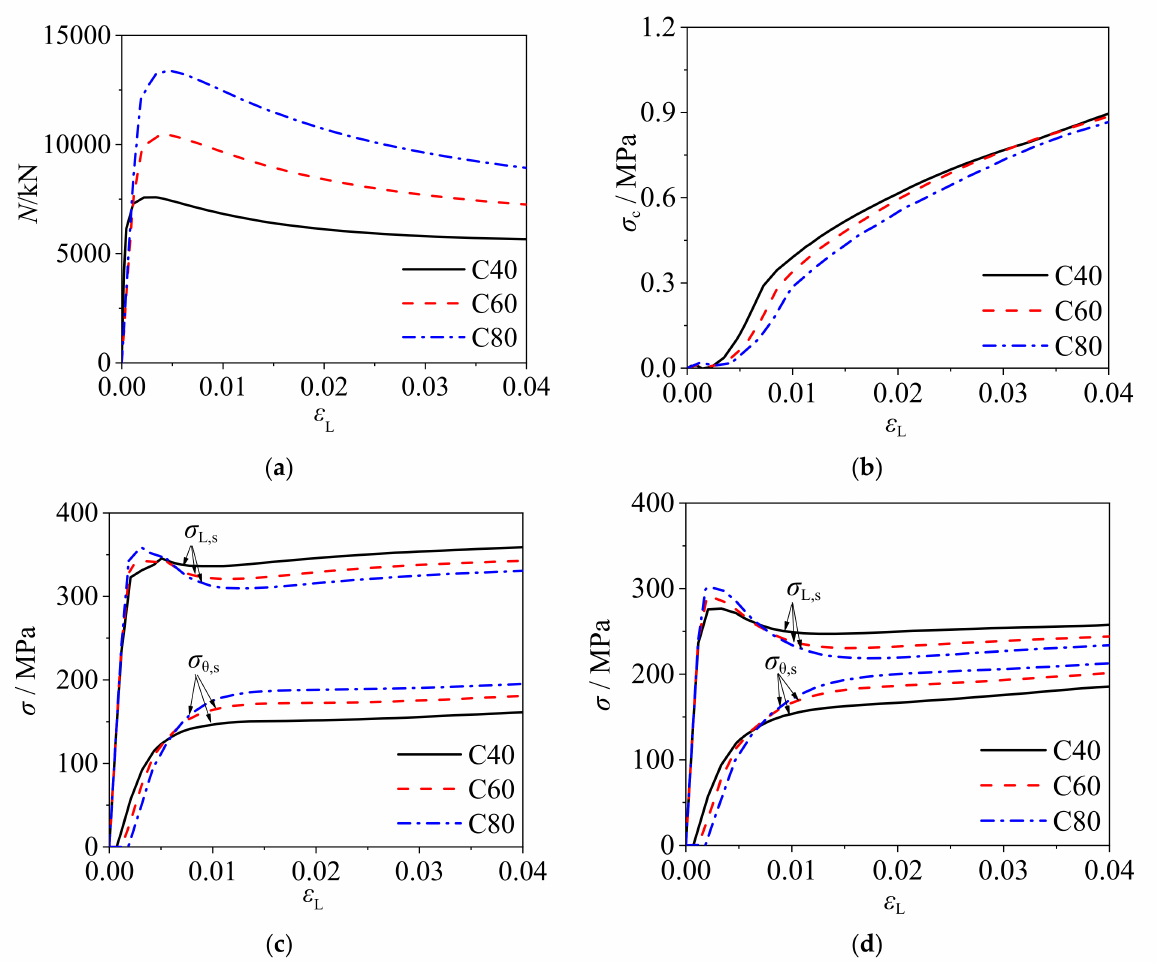
Figure 9. The influence of concrete strength on the mechanical performance of CFCFST stub columns: ( a ) load–strain curves, ( b ) radial stress–strain curves of concrete, ( c ) stress–strain curves of steel tubes at endpoint, and ( d ) stress–strain curves of steel tubes at